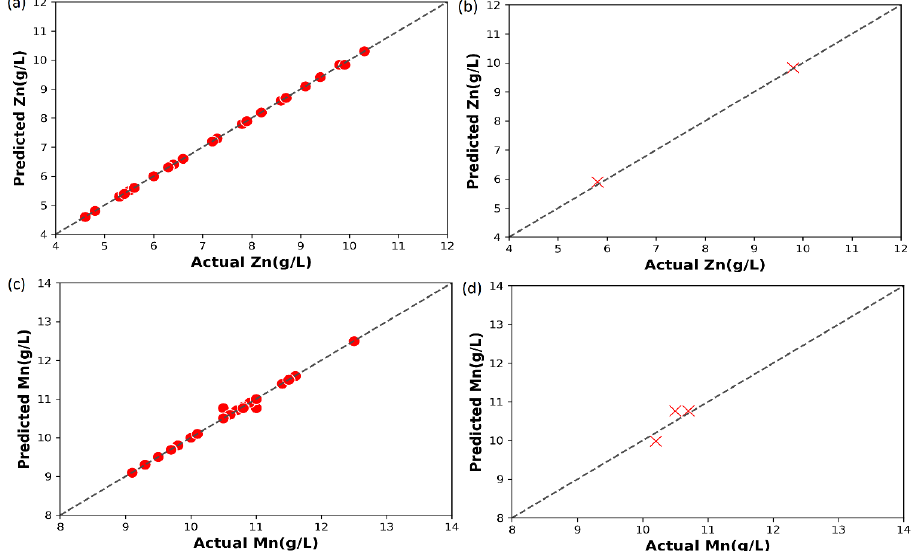
Figure 10. Actual versus XG Boost regression-based predicted ( a ) Zn (g/L) training, ( b ) Zn (g/L) testing, ( c ) Mn (g/L) training and ( d ) Mn (g/L) testing data.